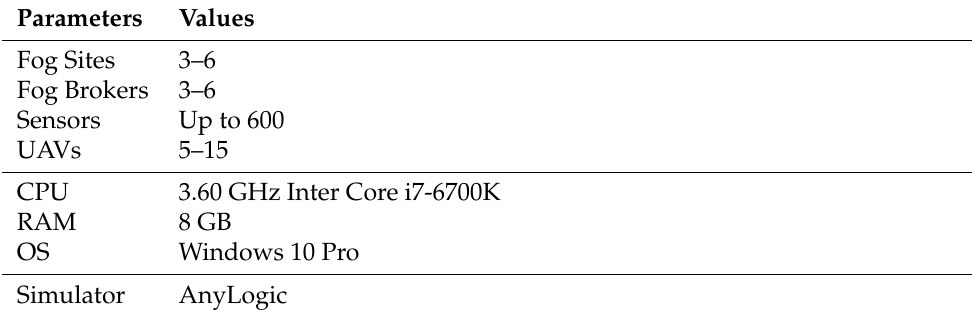
Table 3. Simulation and System